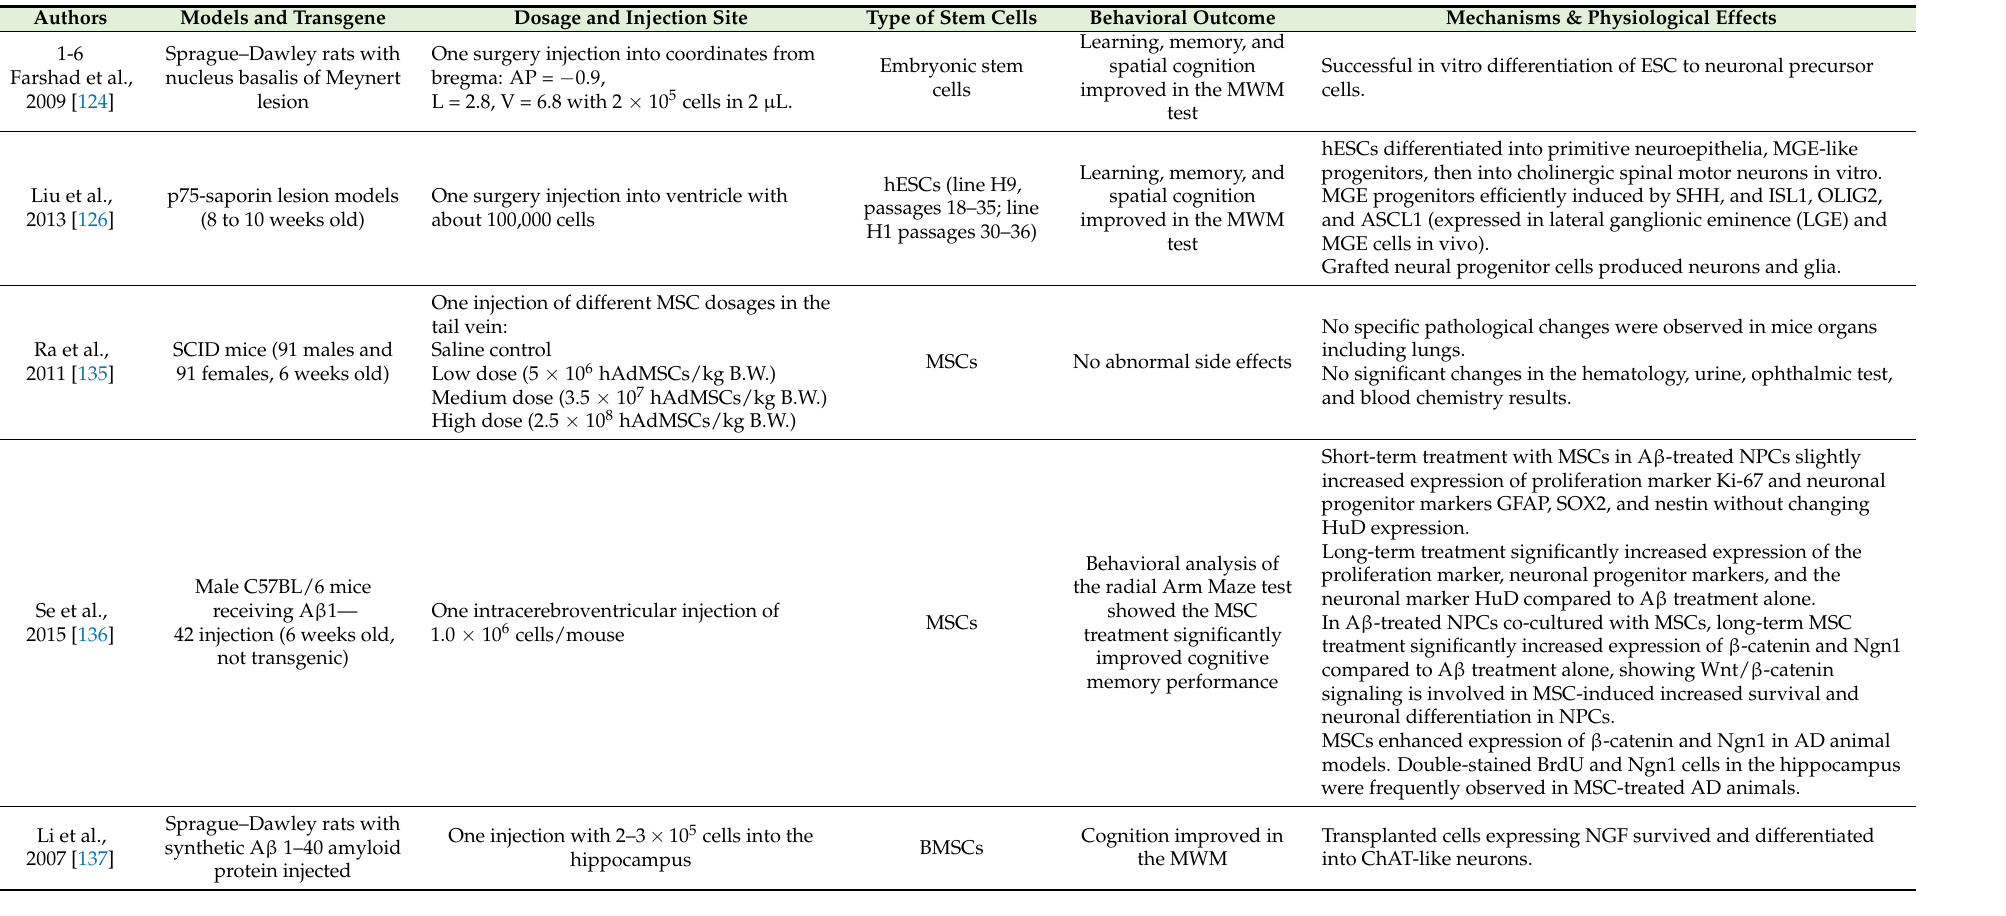
Table 1. Preclinical studies investigating the effectiveness or safety of stem cell therapies in AD animal